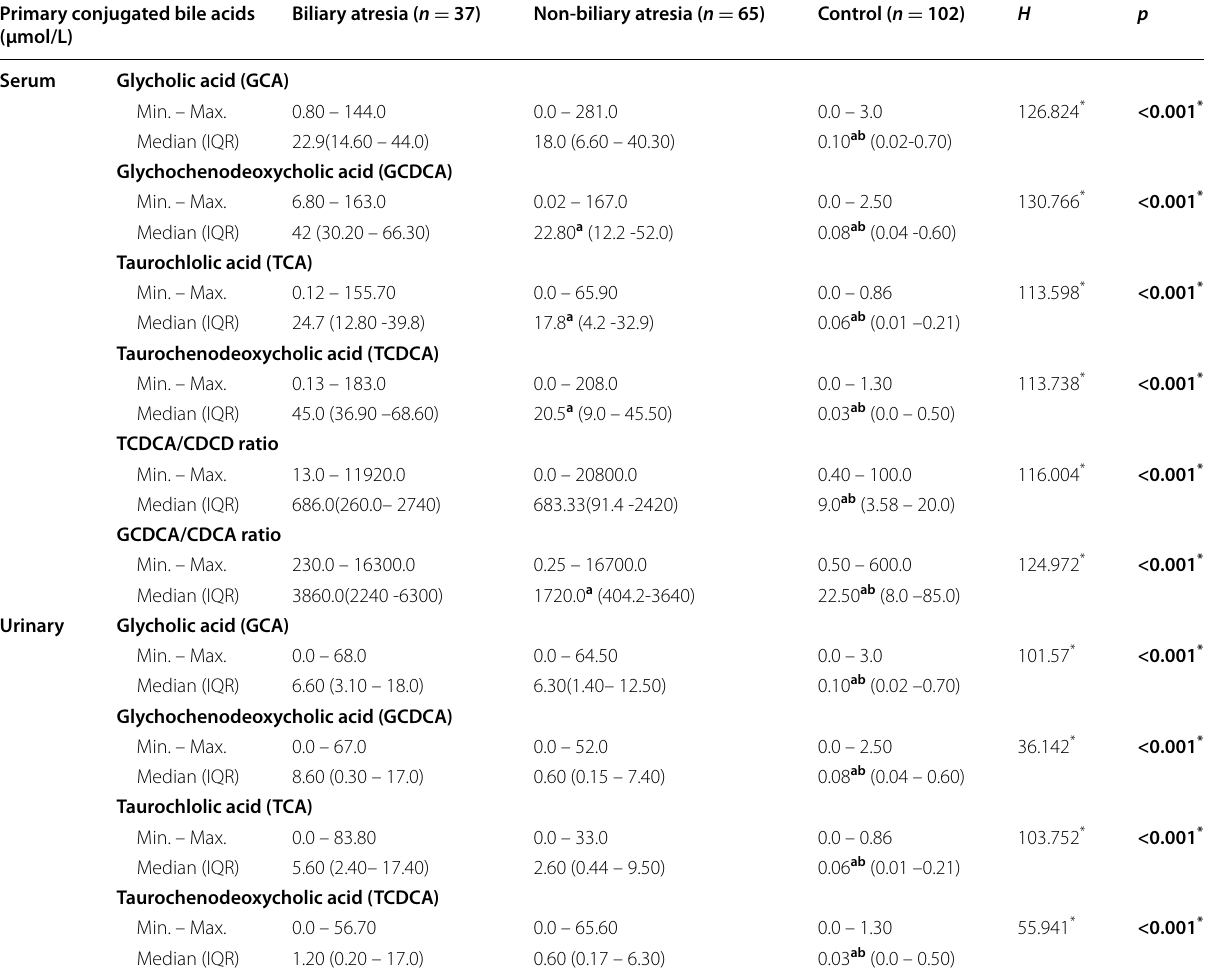
Table 5 Comparison between the two cholestatic groups (BA & non‑BA) and control regarding primary conjugated bile acids in serum and urine